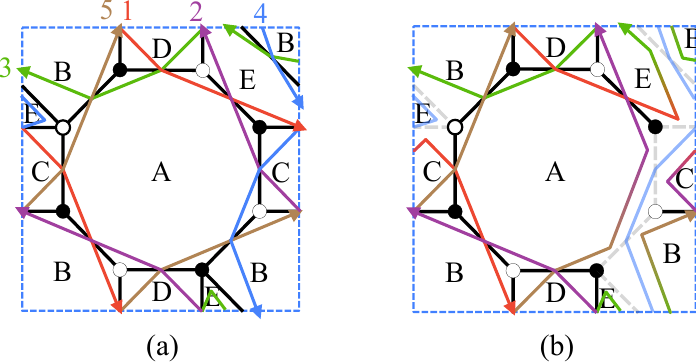
Figure 8. a) Mirror surface for PdP 2 . b) Backreaction of an instanton on face 4 of the dimer, which maps to the blue zig-zag path. All zig-zags recombine into a single one.